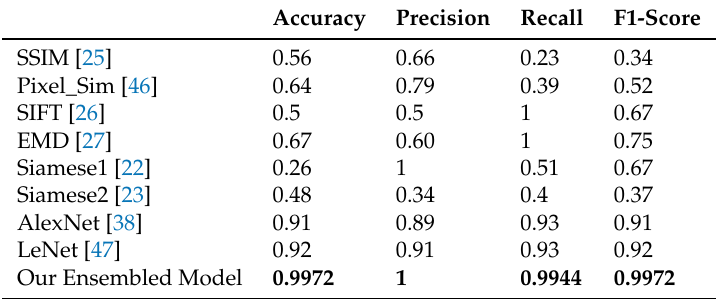
Table 5. Comparison of performance with image similarity based techniques on our dataset. Structured Similarity Index Metric (SSIM), Pixel_Sim, Scale-Invariant Feature Transform (SIFT), and Earth Mover’s Distance (EMD) denote the support vector machine (SVM) models which were built while using the respective features. Accuracy Precision